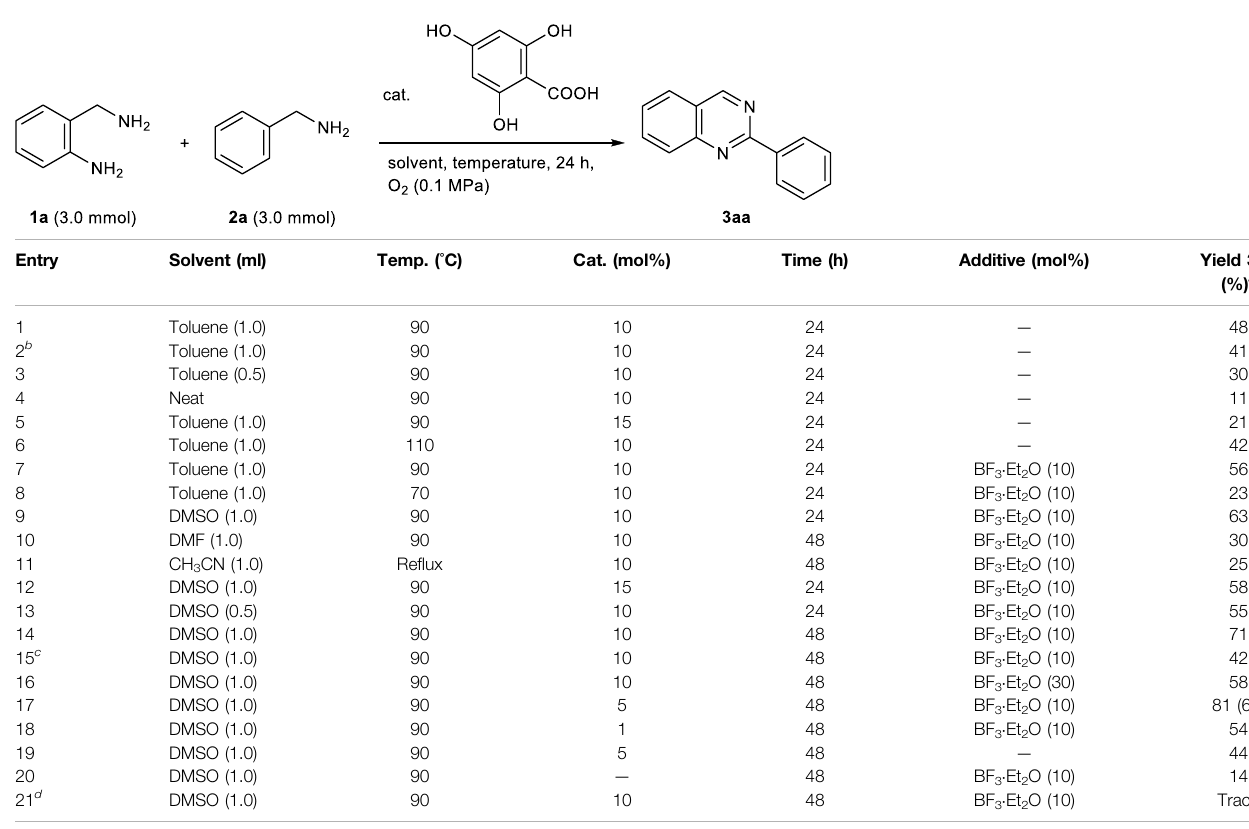
TABLE 1 | Optimization of reaction conditions for the synthesis of 2-phenylquinazoline 3aa